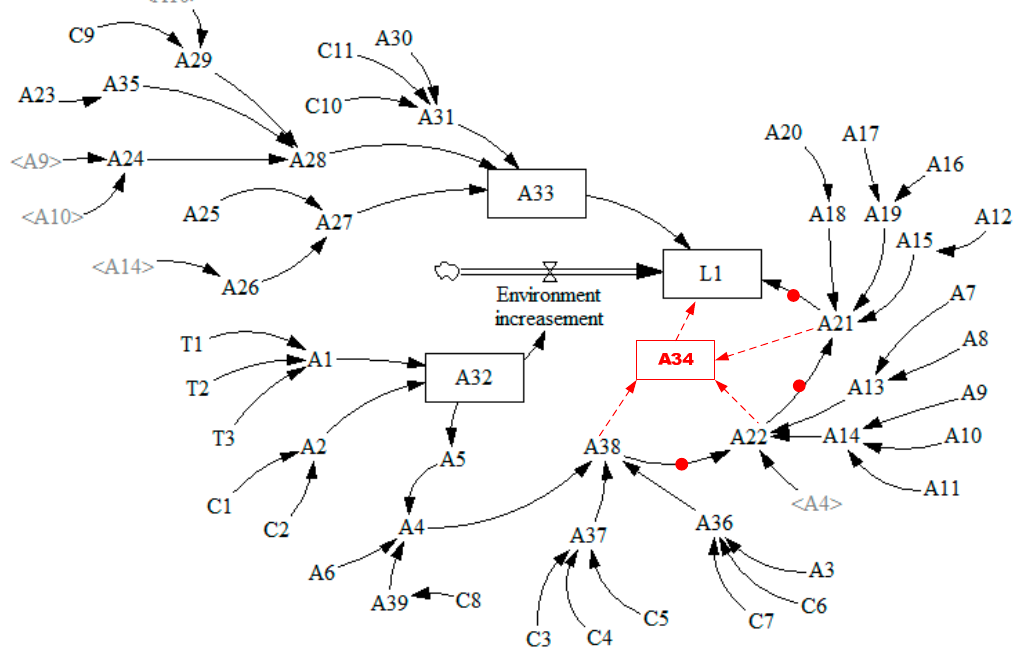
Figure 3. System dynamics (SD) working flow of risk system during fueling process.